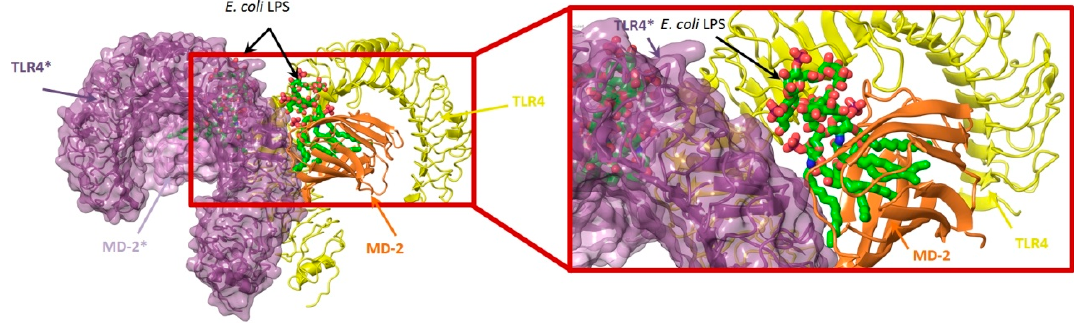
Figure 3. Representation of the X-ray structure of TLR4/MD-2 system (PDB-ID: 3FXI) in complex with Escherichia coli LPS. Right view: detail of the LPS ( green ) bound to TLR4 ( yellow ) and MD-2 ( orange ). Partner TLR4*/MD-2* system is represented in violet colors.